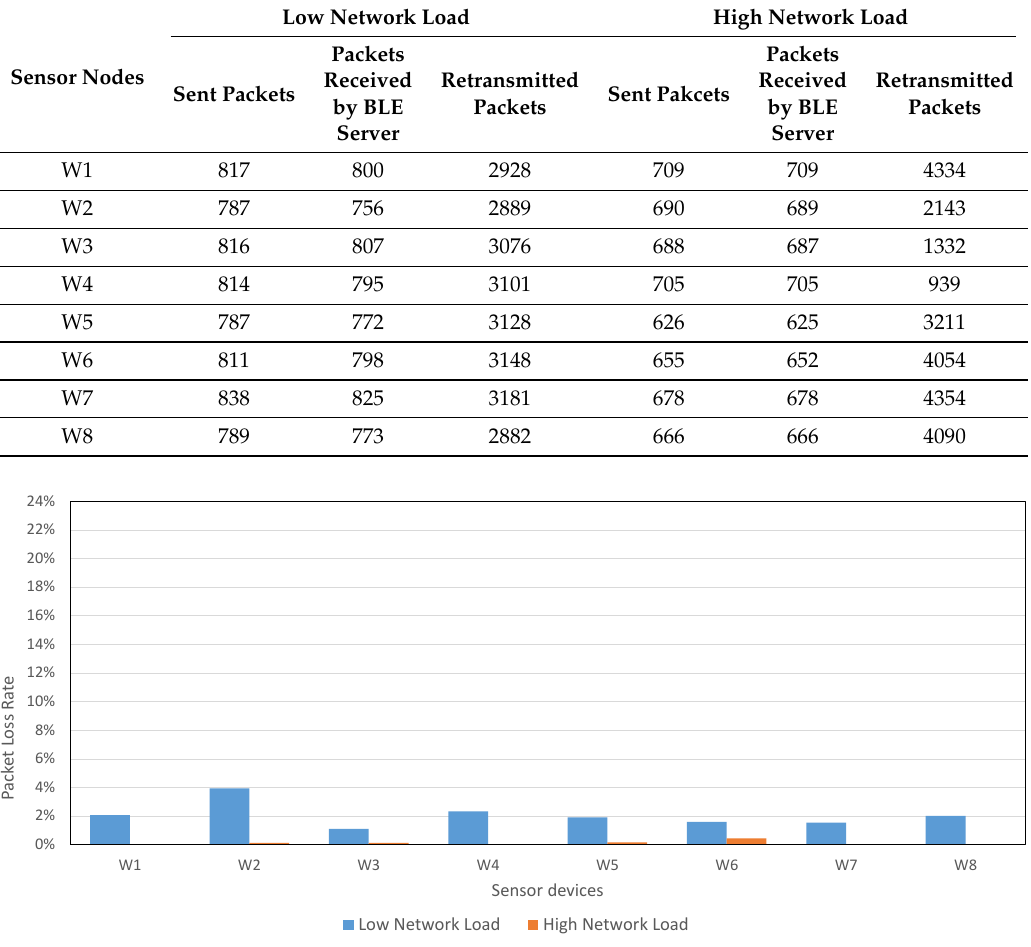
Figure 17. PLR in Collaborative Mesh for 8 sensor devices and 3 CSR devices with default configuration.